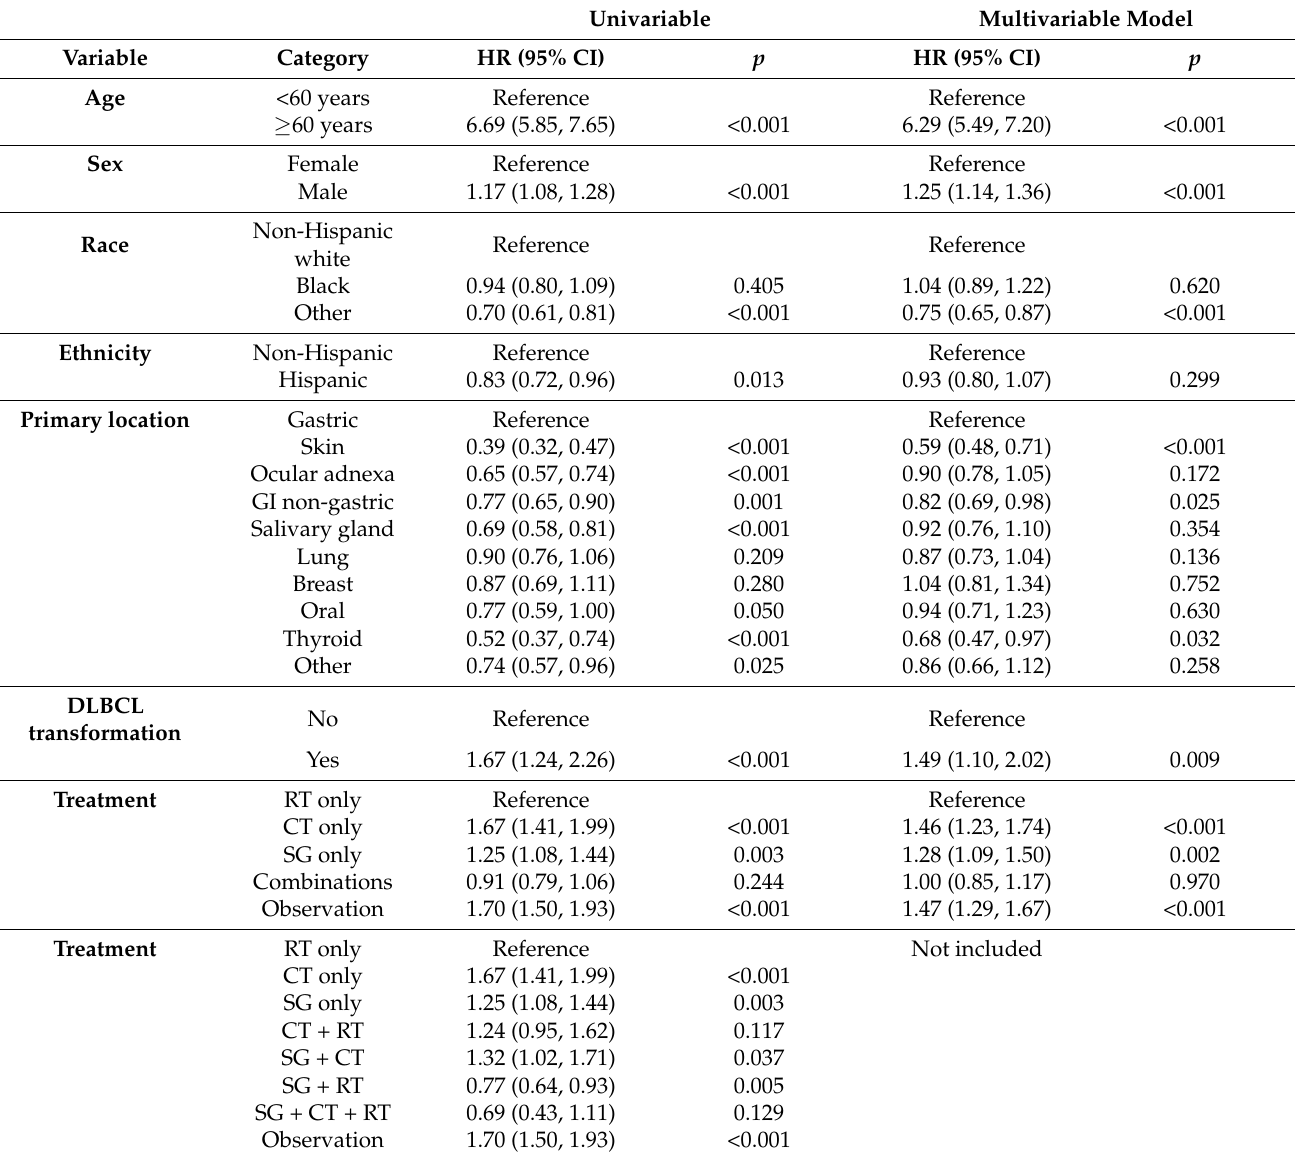
Table 2. Cox models for overall survival in stage I EMZL cohort (N = 7961, including 2073 death events). Univariable Multivariable